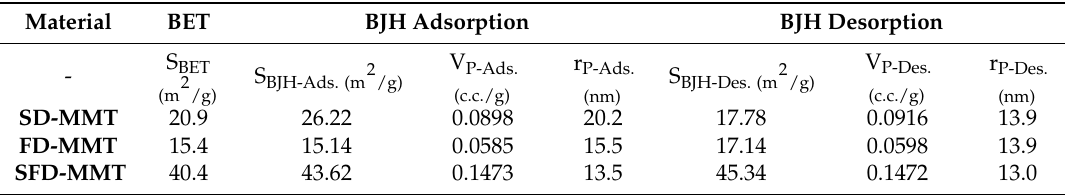
Table 1. Numerical results derived from the BET and BJH methods of the N 2 adsorption–desorption isotherms for MMT samples.